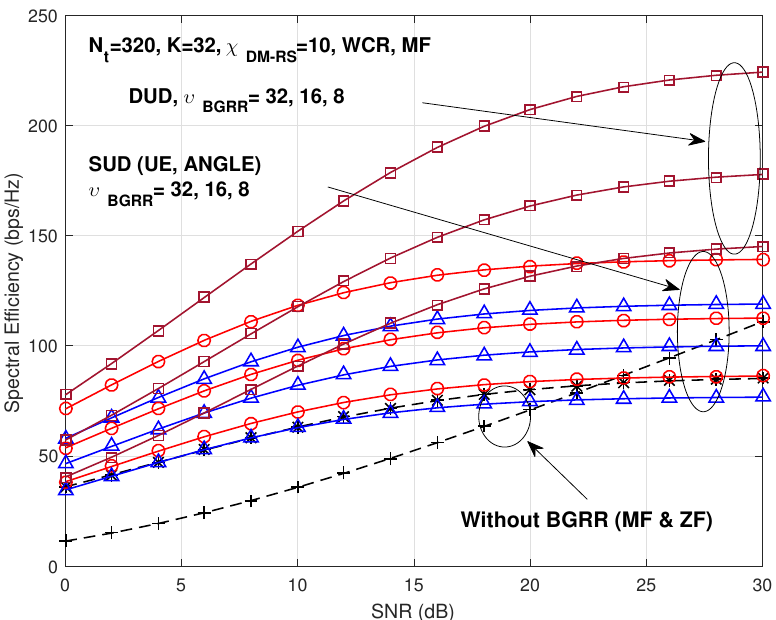
Figure 8. spectral efficiency (SE) (bps/Hz) versus signal-to-noise ratio (SNR) (dB), when N t = 320, K = 32, χ DM − RS = 10, υ BGRR = 32,16, 8, matched filtering (MF) group precoding. Red solid lines with ‘ O ’ marks are the UE based grouping and blue solid ‘ (cid:52) ’ marks are the angle based